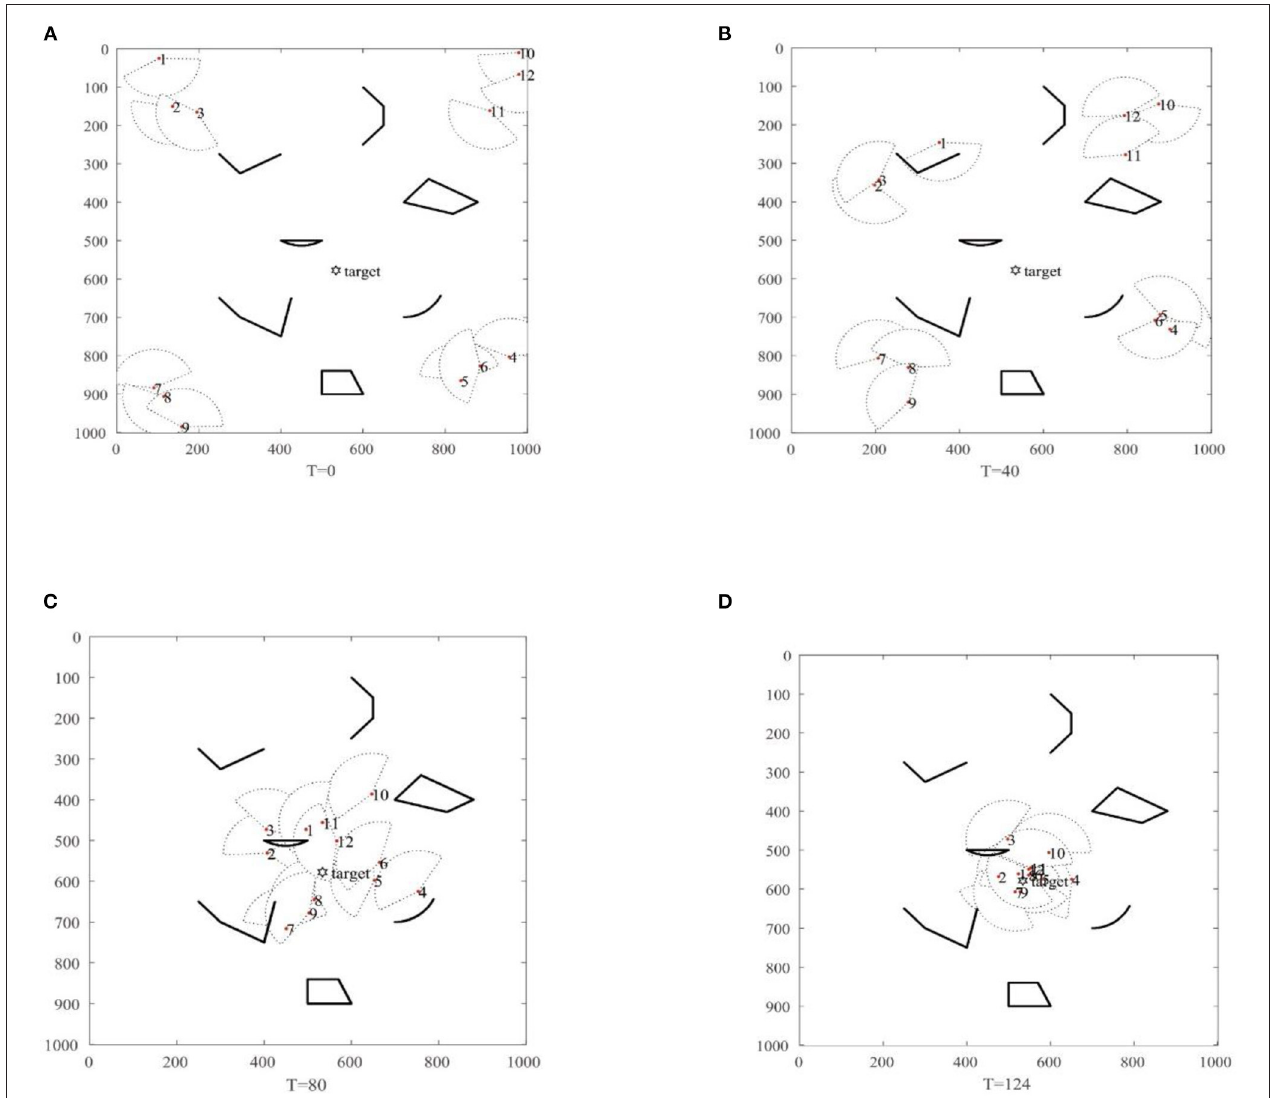
FIGURE 5 | The figure of MSRCPC single-target search. (A) T = 0, (B) T = 40, (C) T = 80, (D) T =